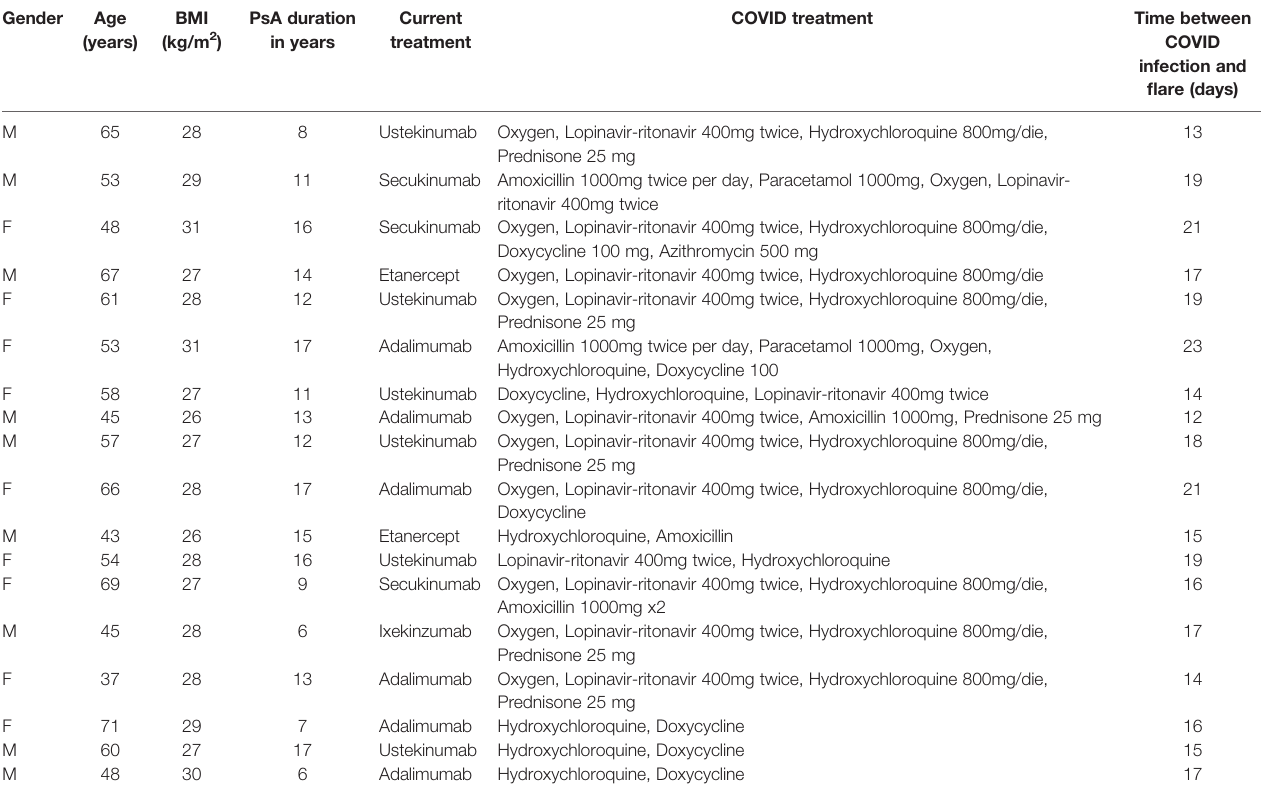
TABLE 1 | Basic demographic information for PsA